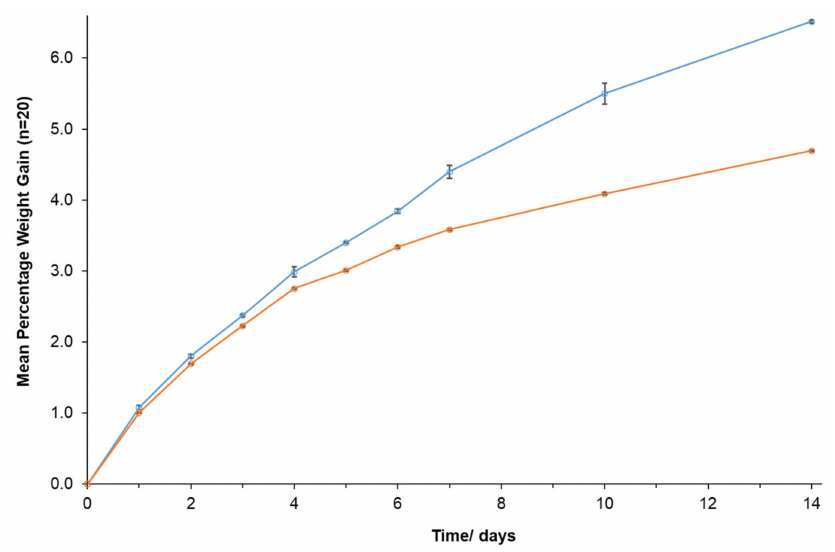
Figure 2. Comparison of weight gain for Micardis ® (blue) and Mizart ® (orange) tablets when repackaged and stored at 30 ◦ C/75% RH. Data shown represent mean ± SEM for (n = 20)